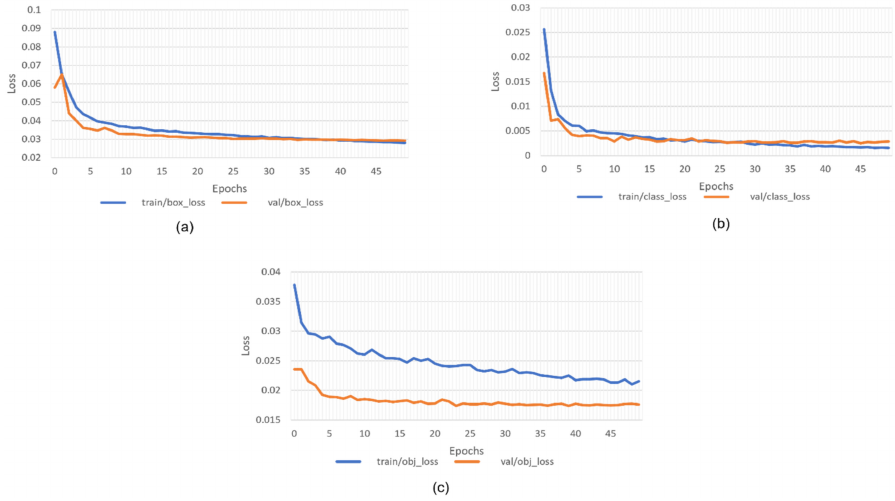
Figure 8. Training and Validation curve of loss for the YOLOv5x model. ( a ) Loss curve for bounding box, ( b ) Loss curve for class, ( c ) Loss curve for object.